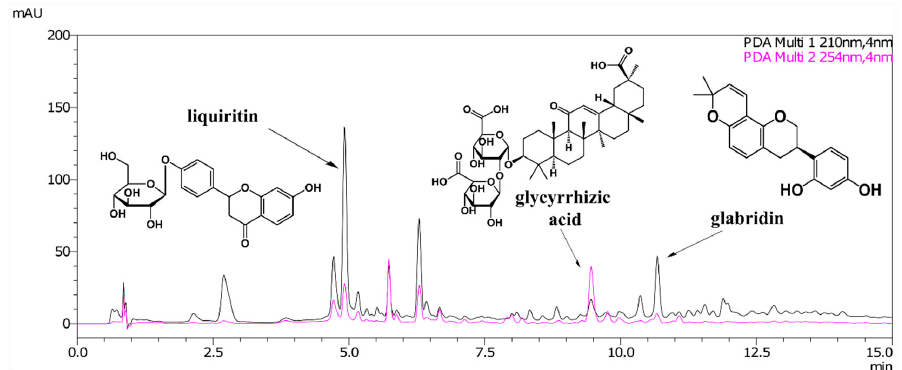
Figure 1. High-performance liquid chromatography (HPLC) chromatogram for the 50% ethanol extract of G. glabra roots.